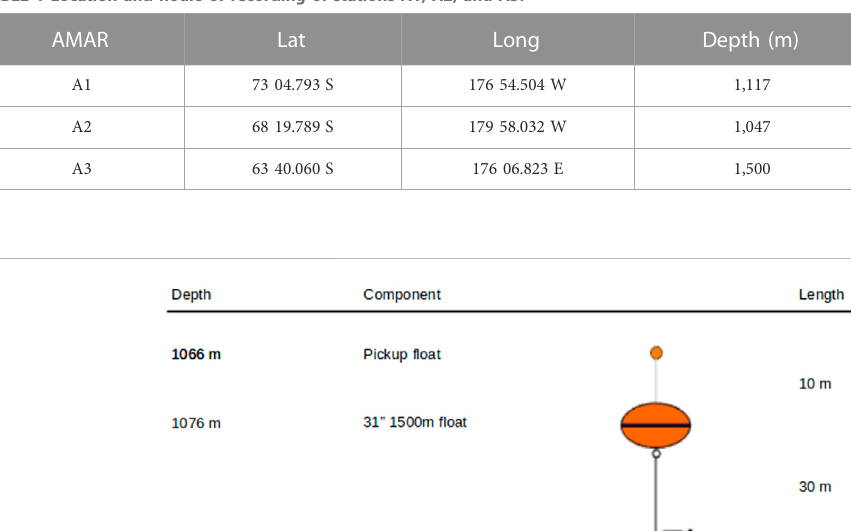
TABLE 1 Location and hours of recording of stations A1, A2, and A3.